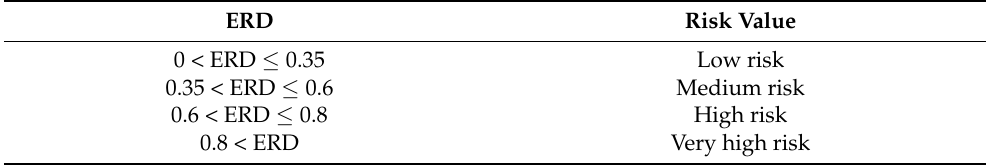
Table 6. ERD indicator classification [33,34]. ERD Risk Value